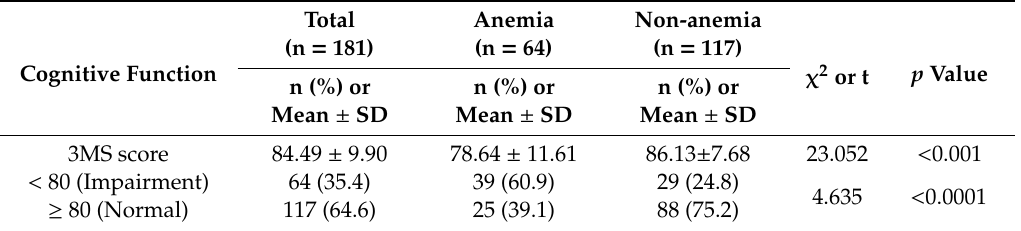
Table 2. Prevalence of cognitive impairment according to patients’ anemic status (n = 181). Cognitive Function